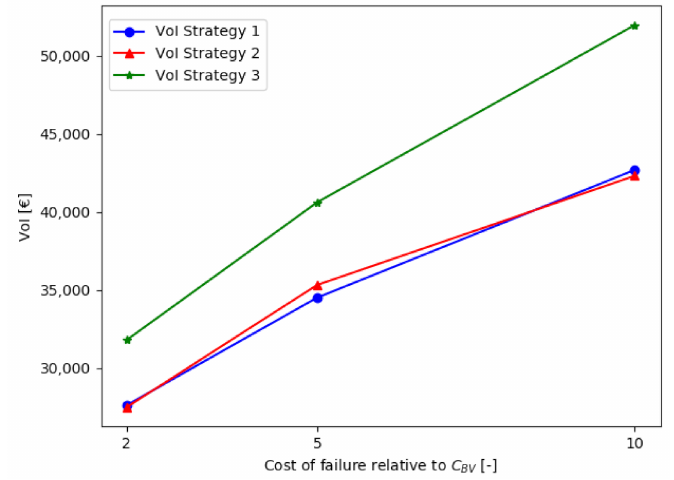
Figure 11. Influence of the cost of failure on the VoI for the three considered monitoring strategies (for the strategies, reference is made to Table